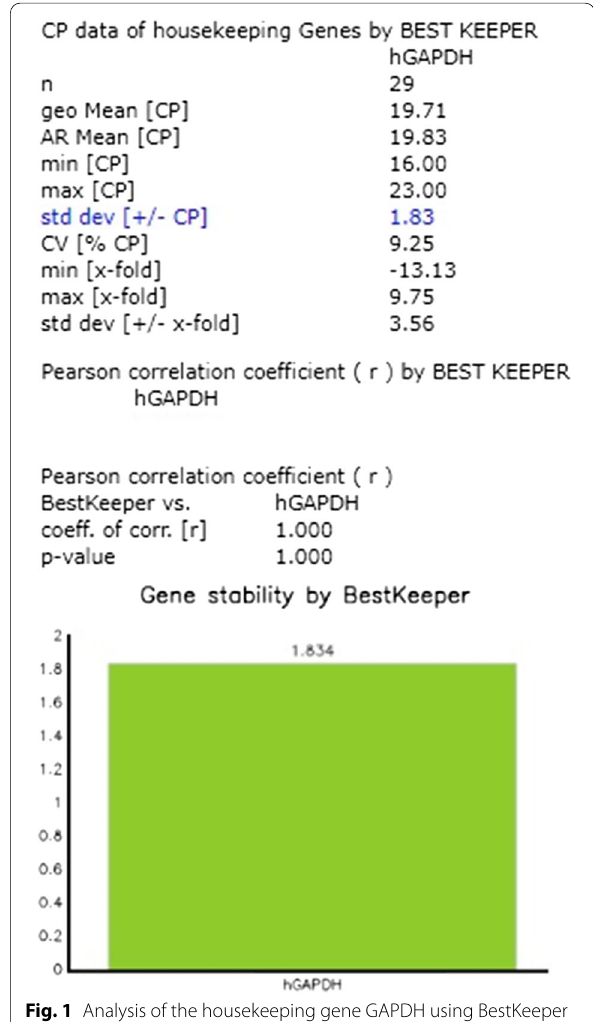
Fig. 1 Analysis of the housekeeping gene GAPDH using BestKeeper tool to determine the stability of the used